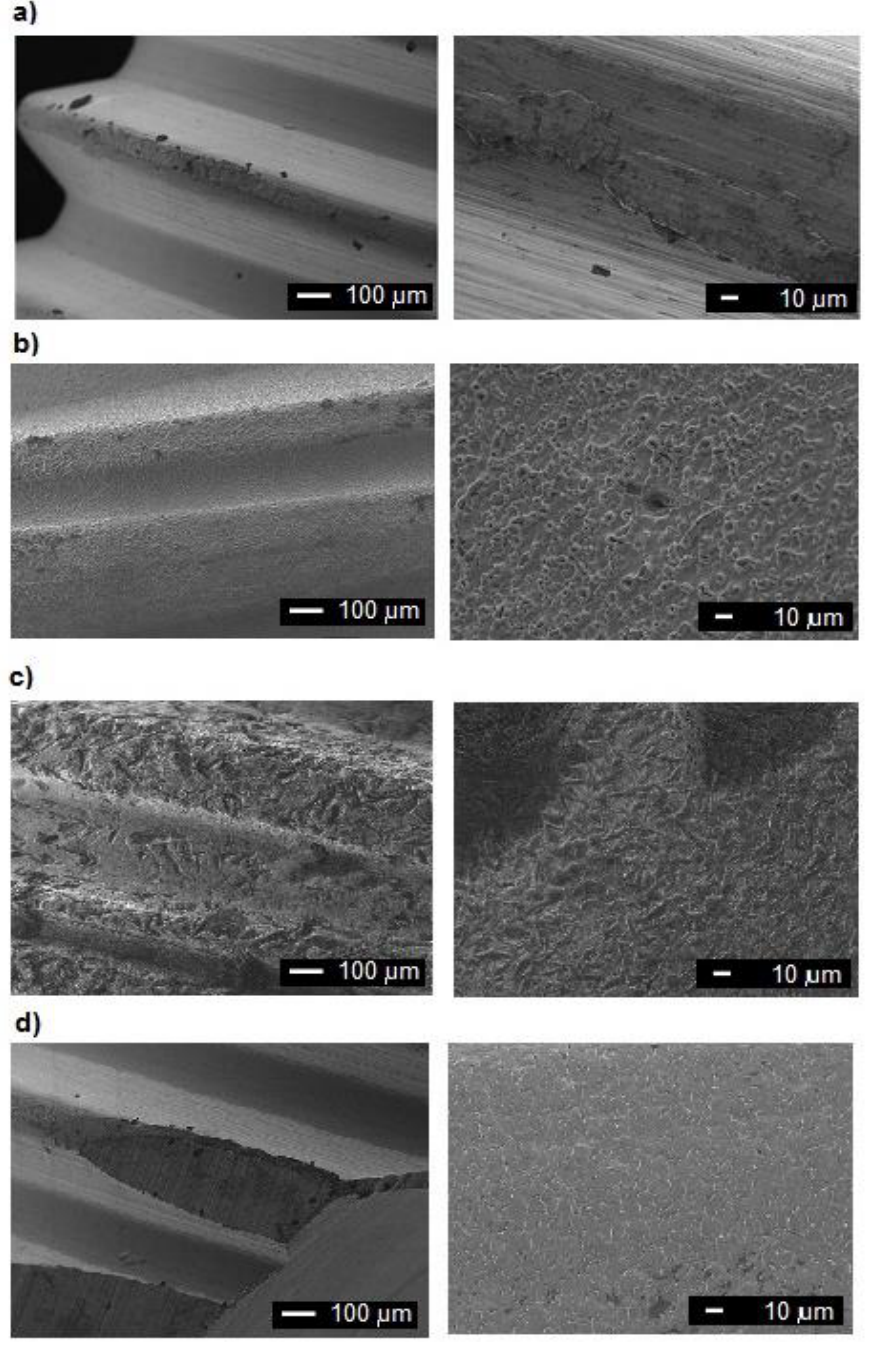
Figure 2. Surfaces of new dental implants: ( a ) A company; ( b ) B company; ( c ) C company; ( d ) D company. SEM.